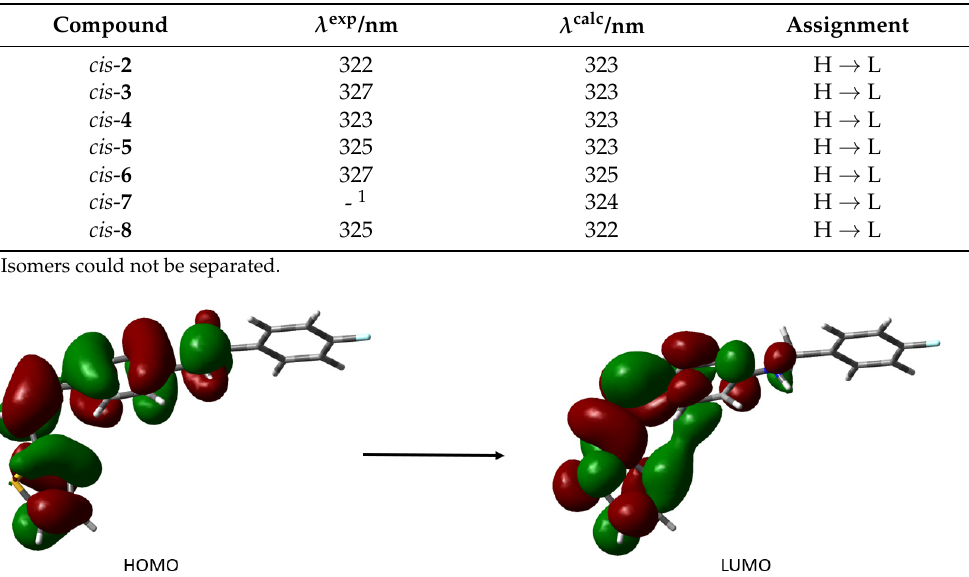
Figure 7. Canonical molecular orbitals involved in transition in UV-Vis spectra of compound cis - 2 .